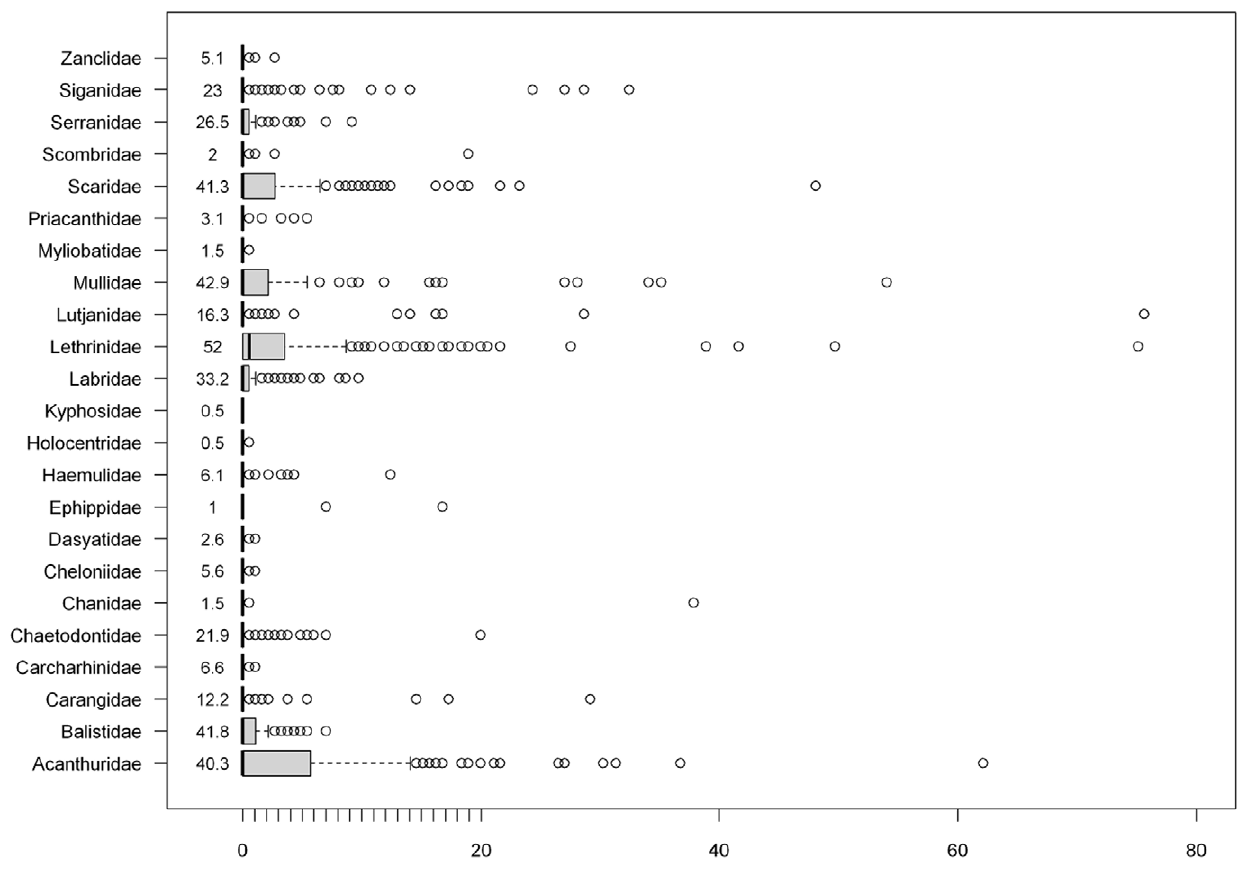
Figure 5. Distribution of abundance density per family. Abundance density was the average over rotations. On each boxplot, boxes showed the interquartile (0.25, 0.75) ranges; whiskers extended to the data point at # 1.5 times the box length away from the box; values outside this range were represented by dots. Four outlying values were not reported for better readability of the plot : 810.6 ind/100 m 2 (two values) and 129.7 ind/ 100 m 2 for Lutjanidae, and 95.5 ind/100 m 2 for Kyphosidae. The frequency (in % stations where the family was seen) was reported on the left of the boxplots for each family.